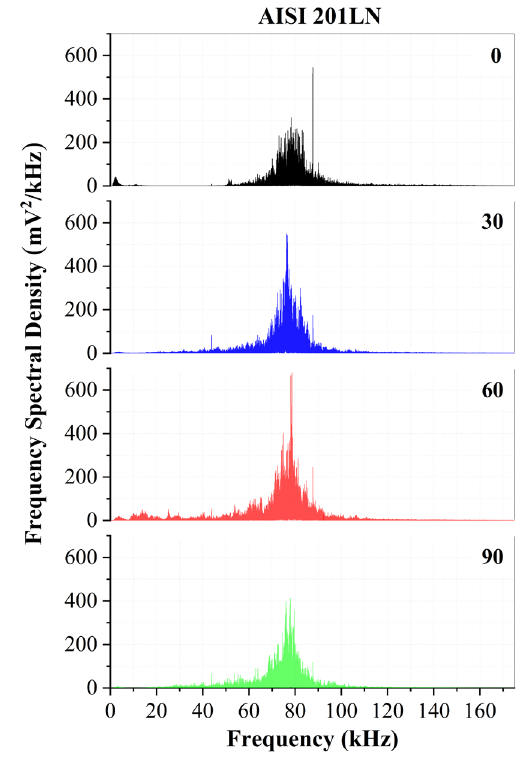
Figure 9. Frequency spectral density for 201LN steel.